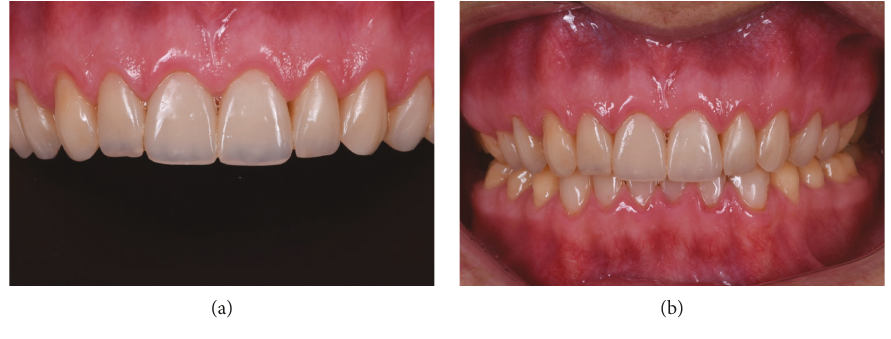
Figure 2: (a, b) 2-year